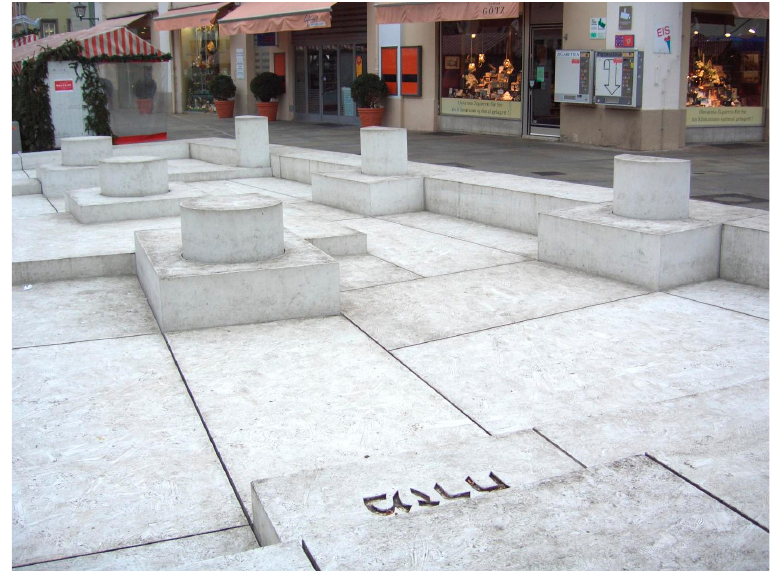
Figure 13. Regensburg (Creative Commons, Dr. Meierhofer).